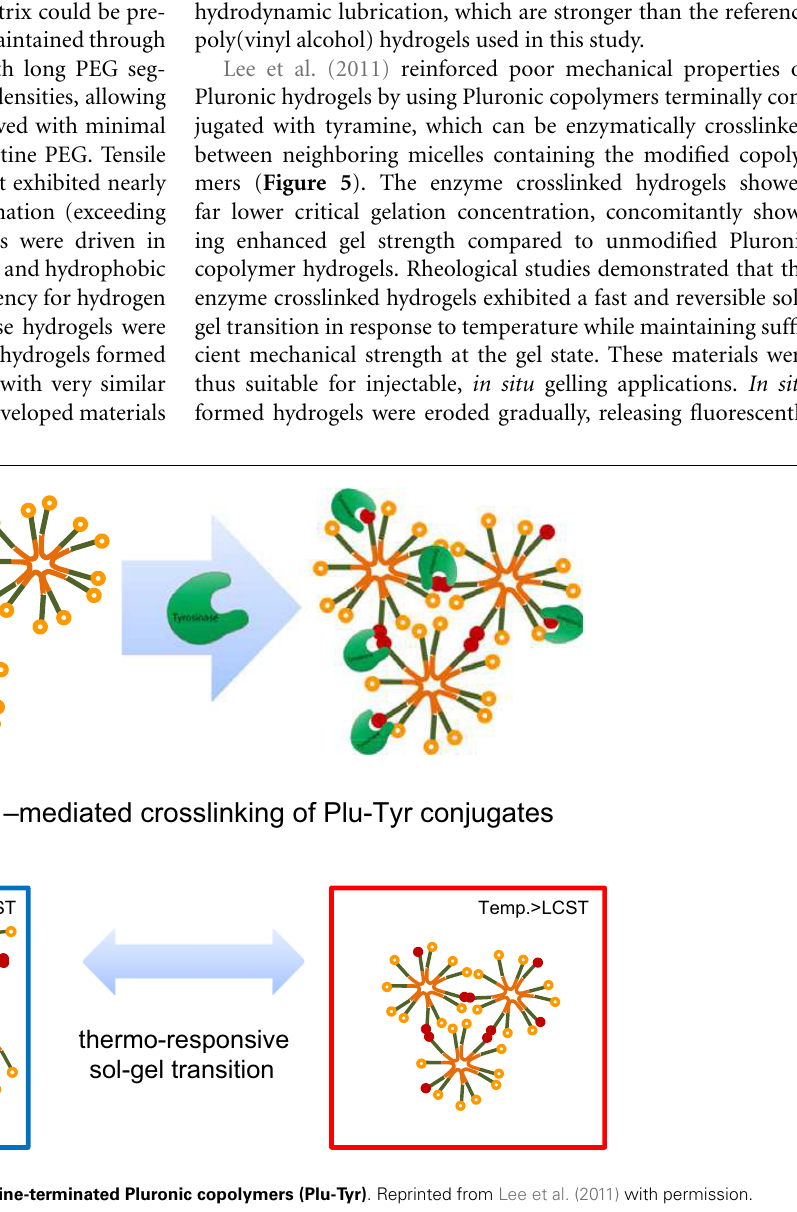
FIGURE 5 |Thermal and enzymatic gelation of tyramine-terminated Pluronic copolymers (Plu-Tyr) . Reprinted from Lee et al. (2011) with permission.